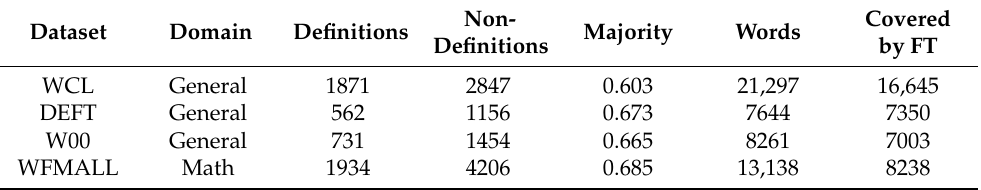
Table 1. Dataset